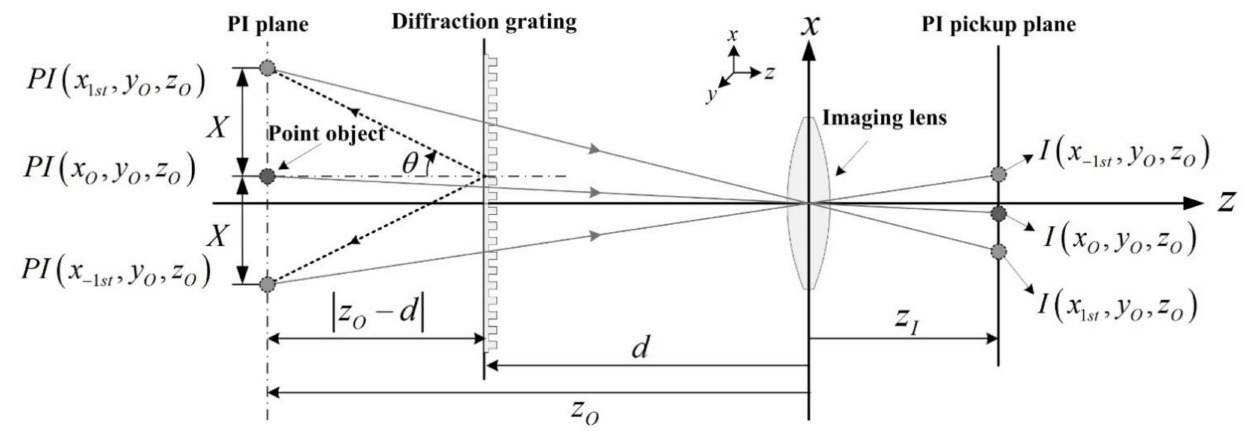
Figure 2. Geometries in diffraction grating imaging among a point object, parallax images (PIs), diffraction grating, an imaging lens, and captured parallax